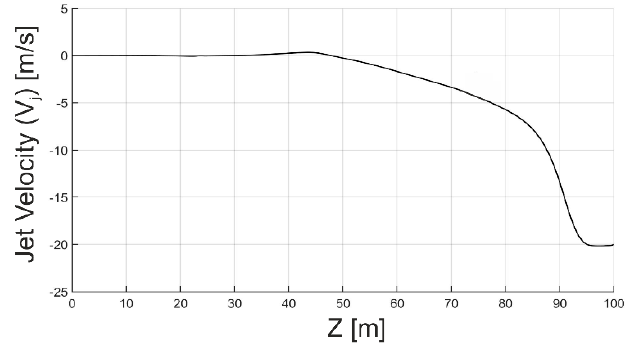
Figure 8. Jet velocity for scenario 4 and a duct velocity of 20 m/s.